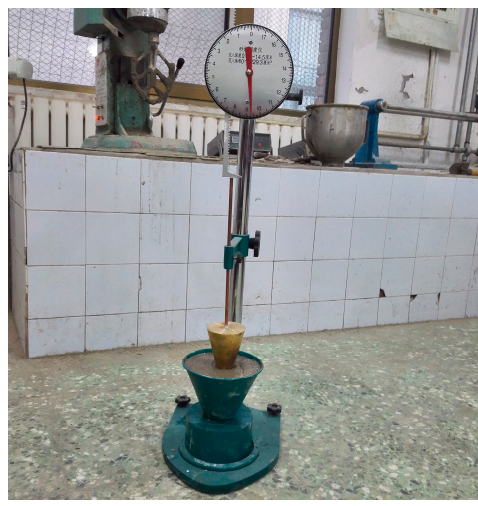
Figure 3. Consistency test of mortars.